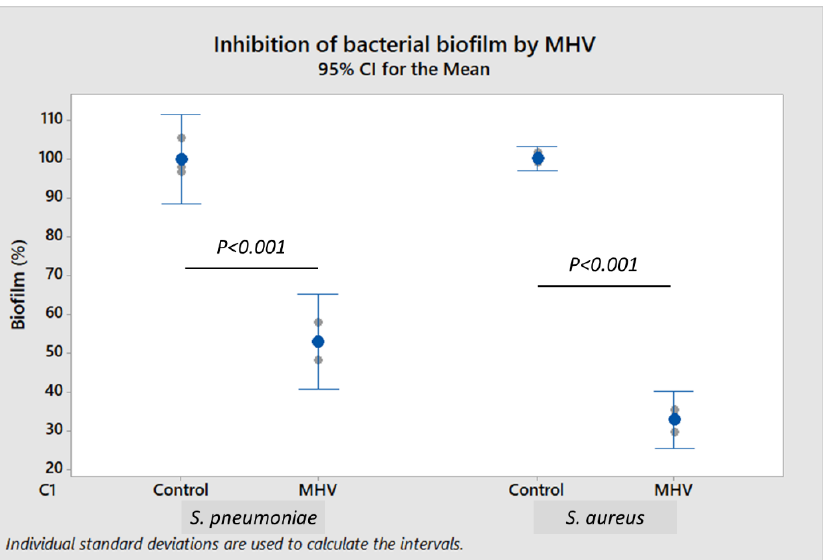
Figure 3. Characterization of biofilm production by S. pneumoniae 19F and S. aureus A10 strains when co-incubated with murine hepatitis virus (MHV) or cell-free culture supernatant (control) using the crystal violet assay. Each result was derived from three independent experiments or biological replicates (with each assay performed as technical triplicates). Each small gray datapoint represents the average or mean of technical triplicates, while each blue datapoint depicts the mean of three independent experiments. Intervals represent 95% CI for the mean. p -value < 0.05 was considered statistically significant by one-way ANOVA with Dunnett’s T3 post-hoc test.